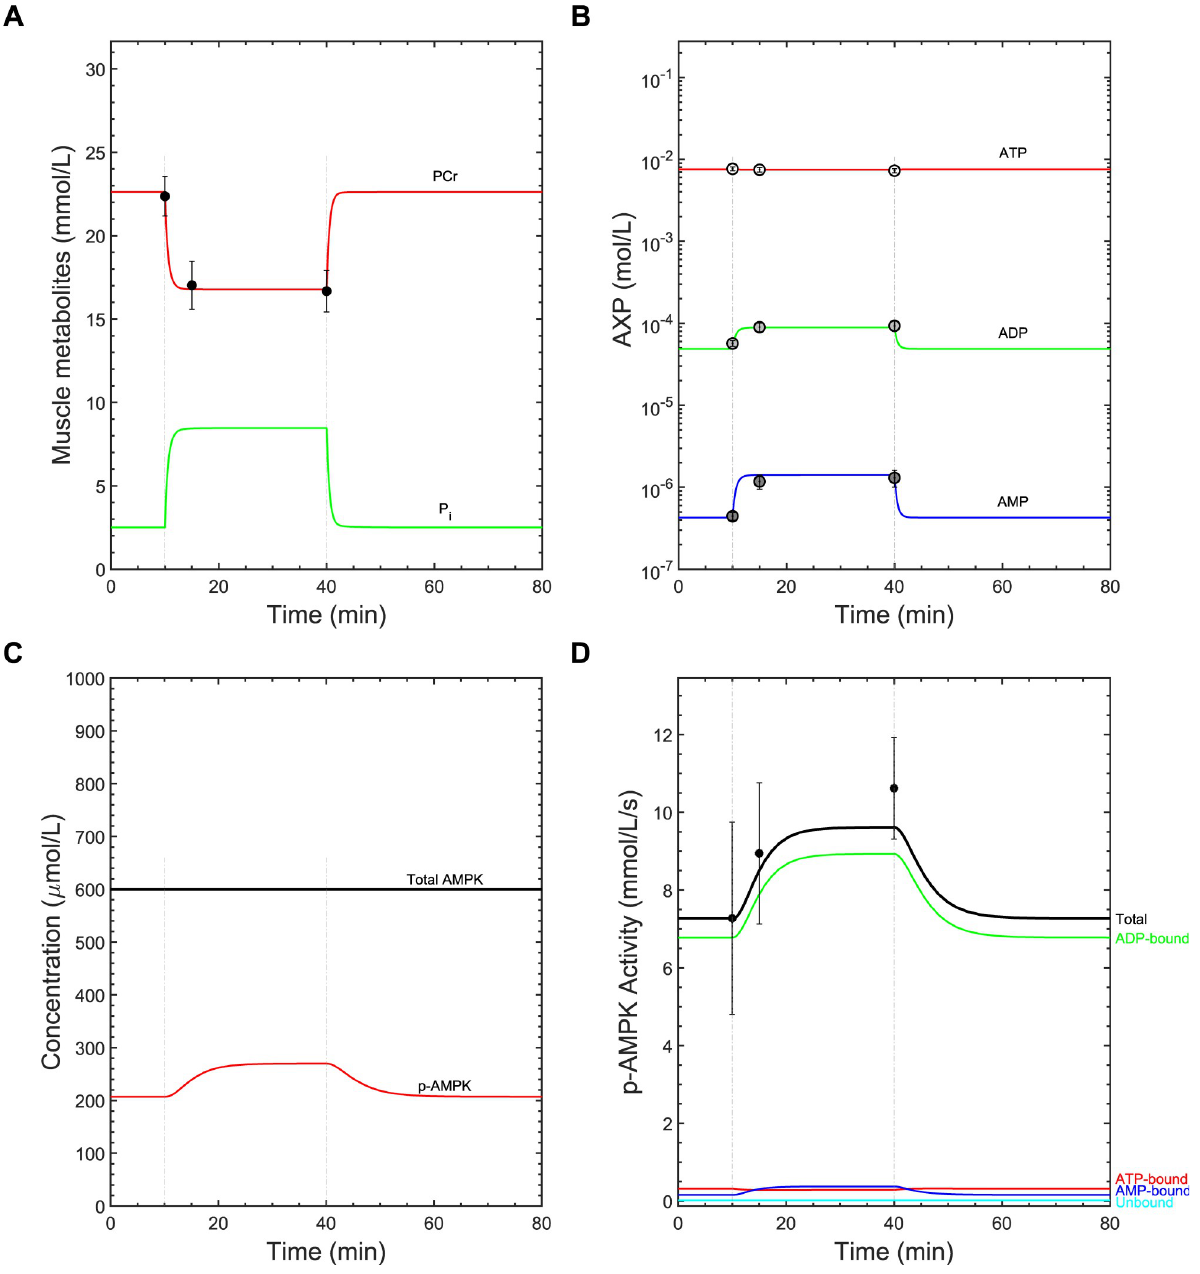
Fig 2. Model calibration results. The model was initially calibrated to data collected from a 30-min submaximal-intensity cycling exercise protocol [5]. For all panels, the measured data are presented as means ± standard error, if available, and the hatched vertical lines indicate the exercise initiation and cessation times. A) Time courses of phosphocreatine (PCr) and inorganic phosphate (P i ) concentrations. The filled circles represent measured PCr concentrations. B) Semi-logarithmic plot showing the time courses of AXP concentrations in response to exercise. The open points, light gray points, and dark gray points represent the measured ATP, ADP, and AMP concentrations, respectively. C) Time courses of the total and phospho-AMPK (p-AMPK) levels. D) Time courses of the simulated kinase activities of each AXP-bound phospho-AMPK (AXP-p-AMPK) complex. Filled circles represent the measured mean relative change in total AMPK activity between rest and